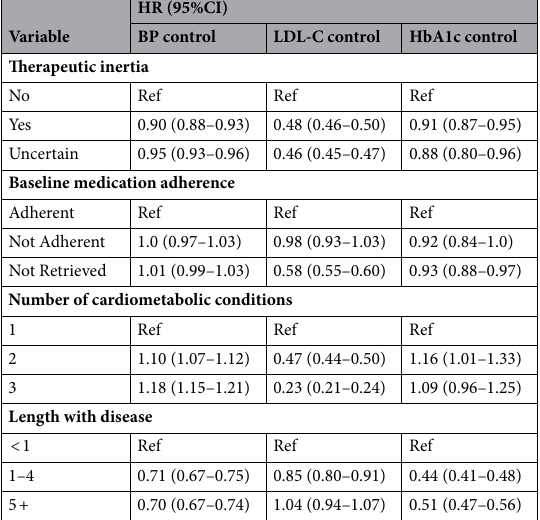
Somers’ D for reduced model without Medication adherence variable